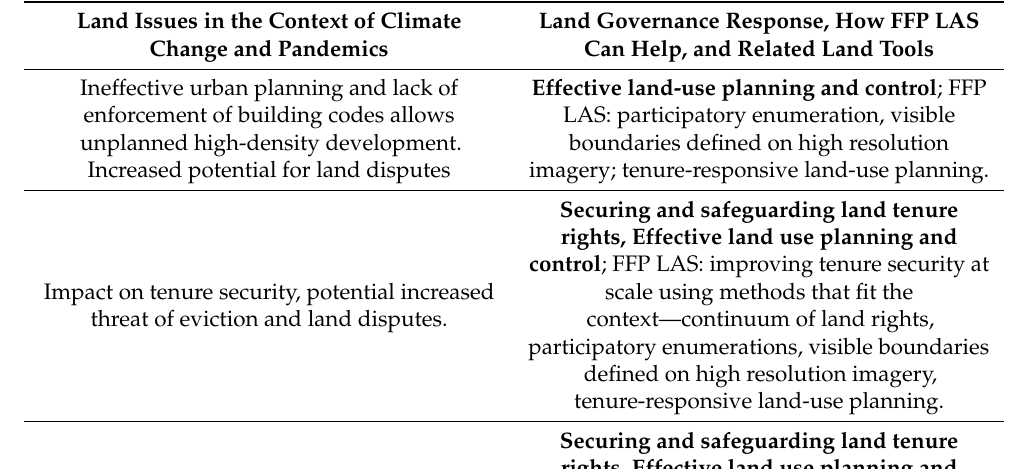
Table 4. Land governance and FFPLAS responses to land issues in the context of climate change and